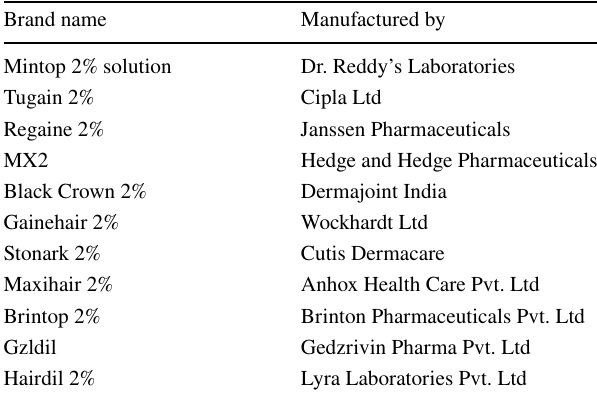
Table 15 Alternative brand available for Regero Brand